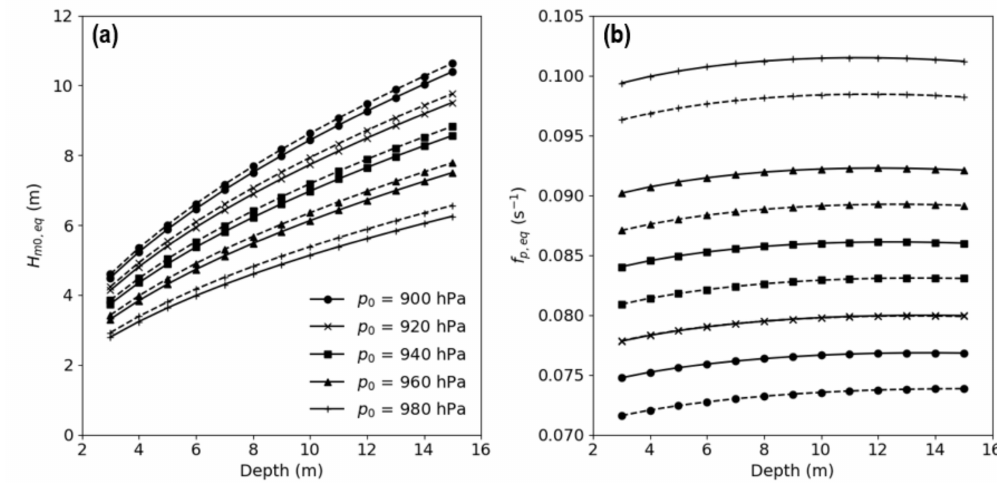
Figure 4. ( a ) Significant wave height and ( b ) peak frequency of maximum combined swell/wind-sea hurricane waves at various shallow depths and eye pressures determined via the parametric model for V fm = 5 ms − 1 (solid line) and V fm = 10 ms − 1 (dashed line).